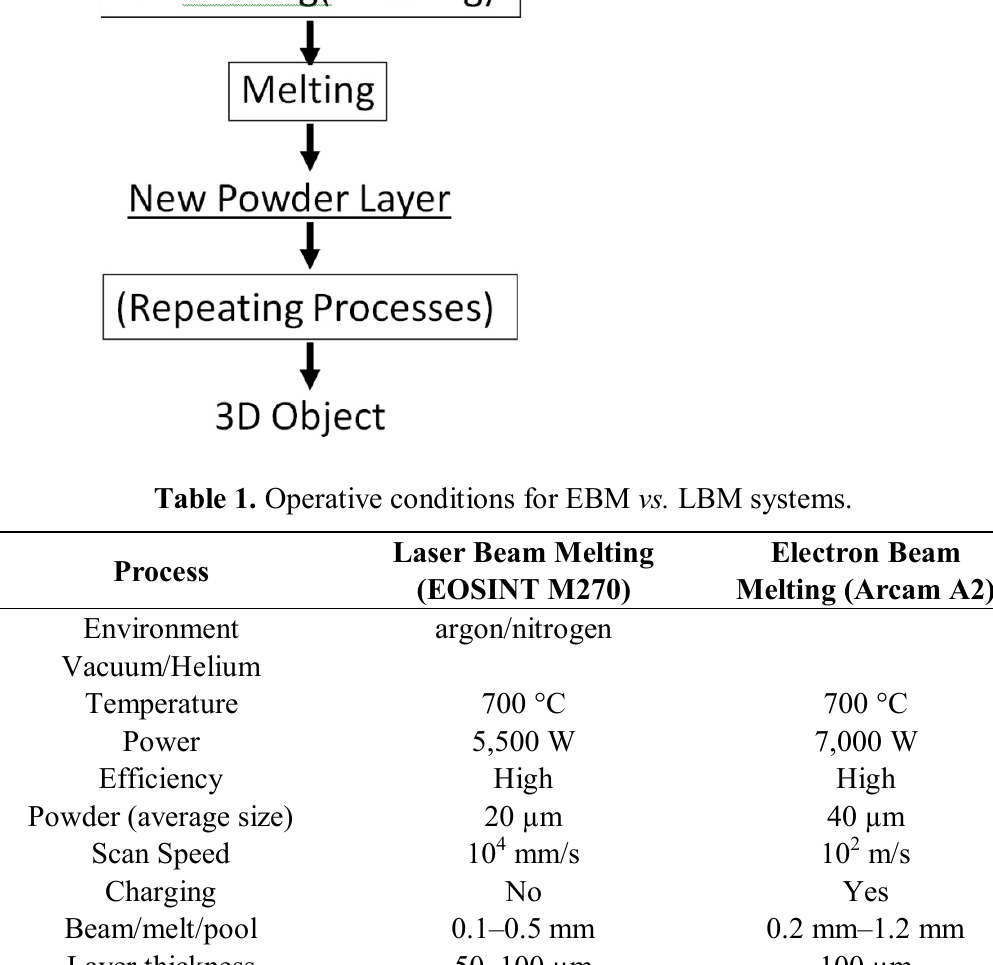
Table 2. Using each alloy powder, for each corresponding equipment, three types of specimens, dumbbell-shaped specimens (20 mm gauge length, 3 mm diameter) for the tensile test; and two kinds of plate specimens (10 mm × 10 mm × 2 mm or 30 mm × 30 mm × 4 mm) for the metallography, the evaluation of corrosion behavior and grindability were